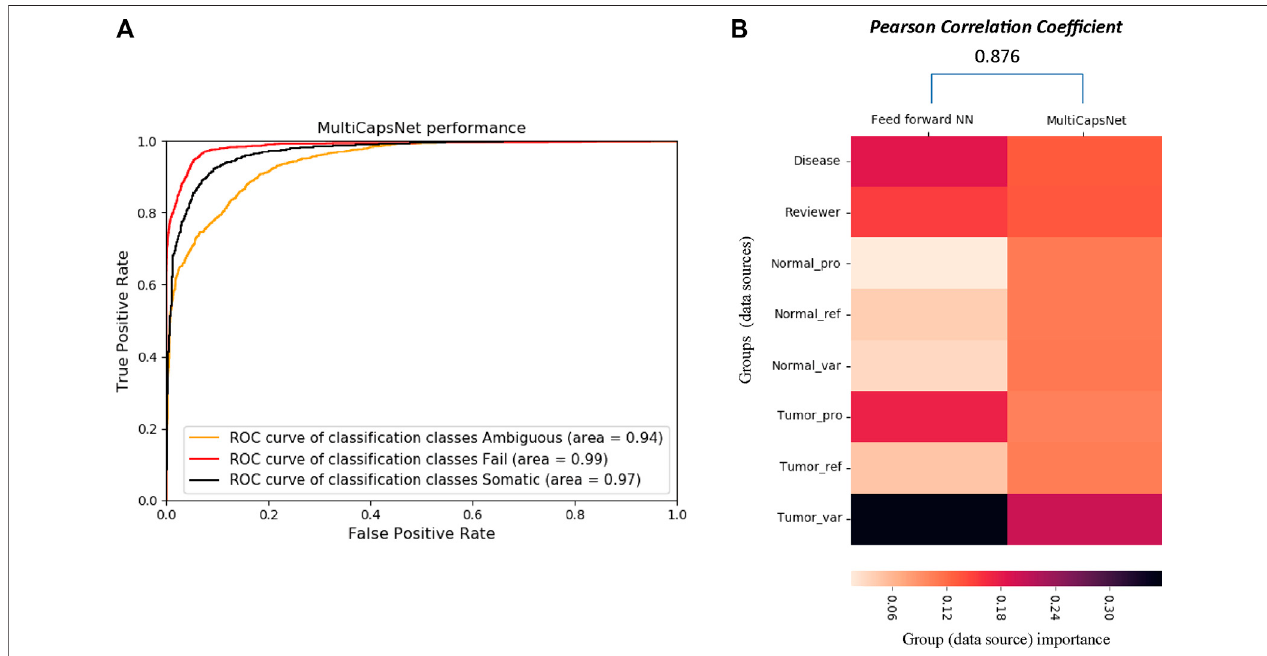
FIGURE 3 | Architecture of MultiCapsNet integrated with prior knowledge. (A) The model has two layers. The fi rst layer consists of 696 parallel neural networks corresponding to696 primary capsules labeled with either transcription factor (348) or protein-protein interactioncluster node (348). The inputs ofeach primary capsule include genes regulated by a transcription factor or in a protein-protein interactions sub-network. The second layer is the Keras implementation of CapsNet for classi fi cation. The length of each fi nal layer type capsule represents the probability of input data belonging to the corresponding classi fi cation category. (B) Alternative representation of MultiCapsNet integrated with prior knowledge. Genes that are regulated by a transcription factor or in a protein-protein interactions sub- network, are groups together as a data source for MultiCapsNet. Figures 3A,B are equivalent with different representation.